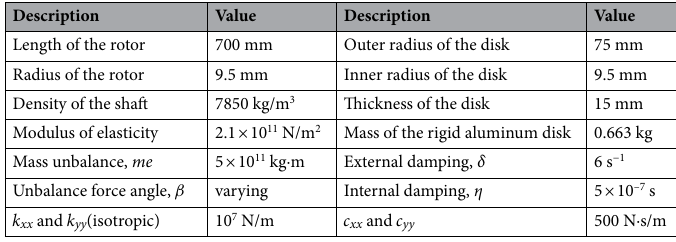
Table 1. Physical parameters of the